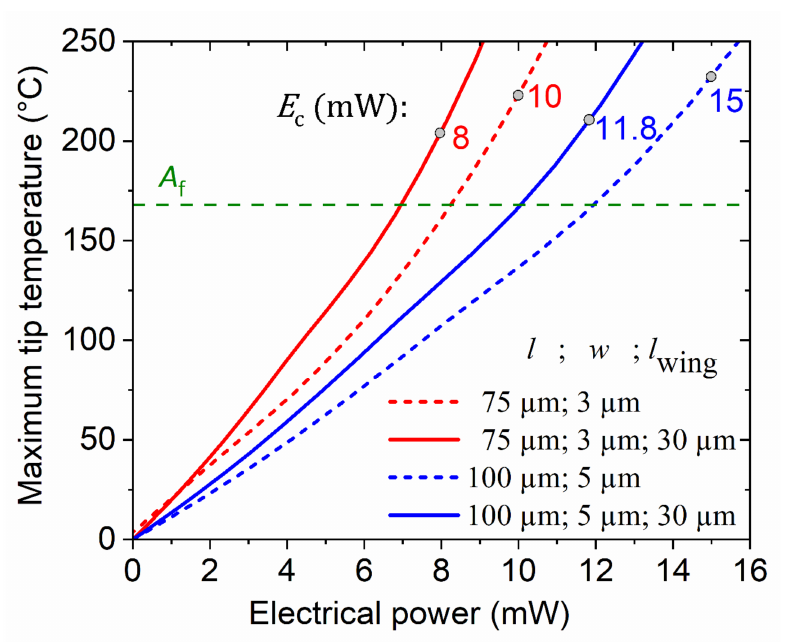
Figure 6. Simulated characteristics of maximum temperature at the cantilever beam tip as a function of electrical heating power. Measured values of electrical power (dots) are compared to simulation results to estimate the maximum temperature at the cantilever beam